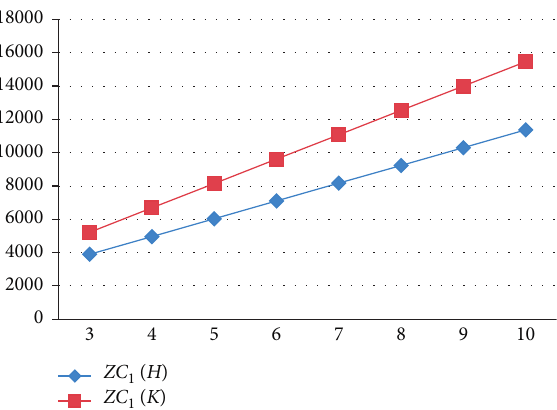
Figure 3: Comparison of ZC